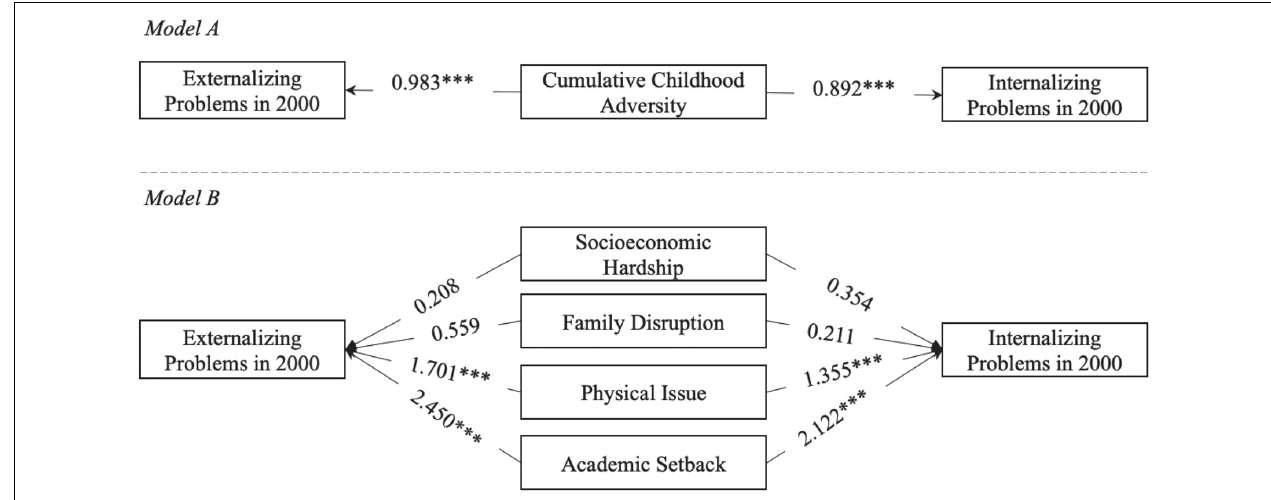
FIGURE 2 | Illustration of the associations between childhood adversity and childhood mental health in childhood. Age and gender are not shown in this figure for simplicity. Numbers on arrows are unstandardized regression coefficients. ∗ < 0.05, ∗∗ < 0.01, ∗∗∗ < 0.001.